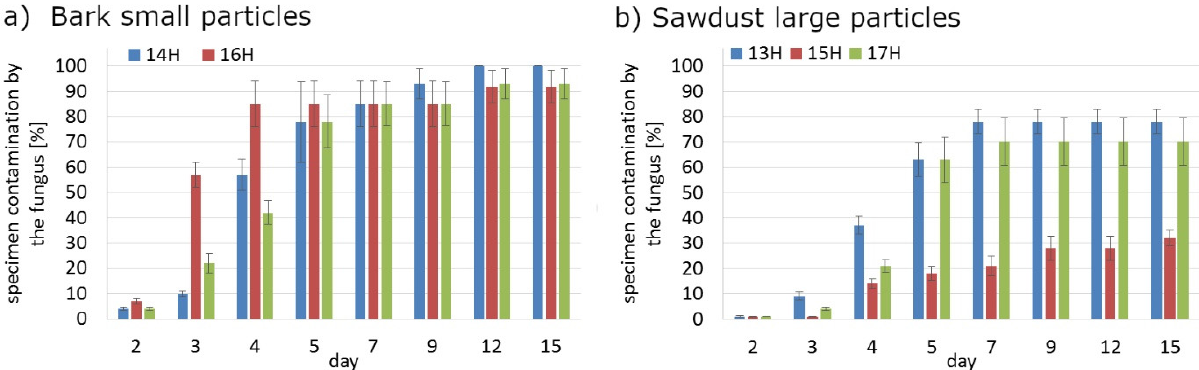
Figure 9. The rate of surface fouling by fungi Aspergillus niger Tiegh of HDPE composites with MAHPE addition; ( a ) bark small particles; ( b ) sawdust large particles.